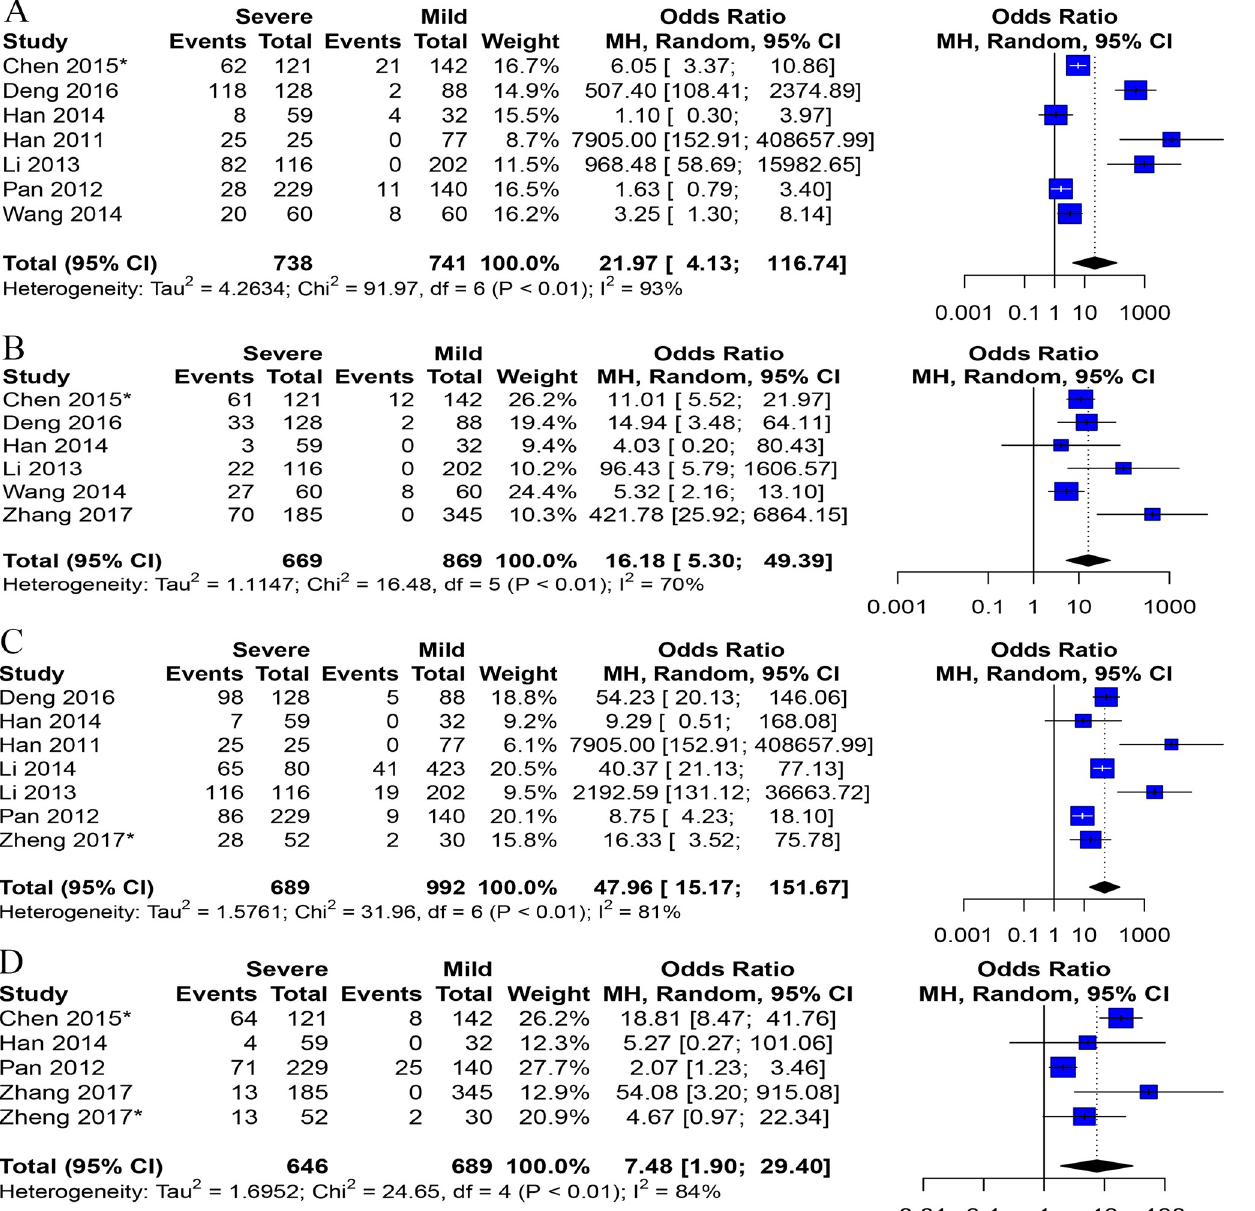
PLOS ONE | https://doi.org/10.1371/journal.pone.0267716 April 28,